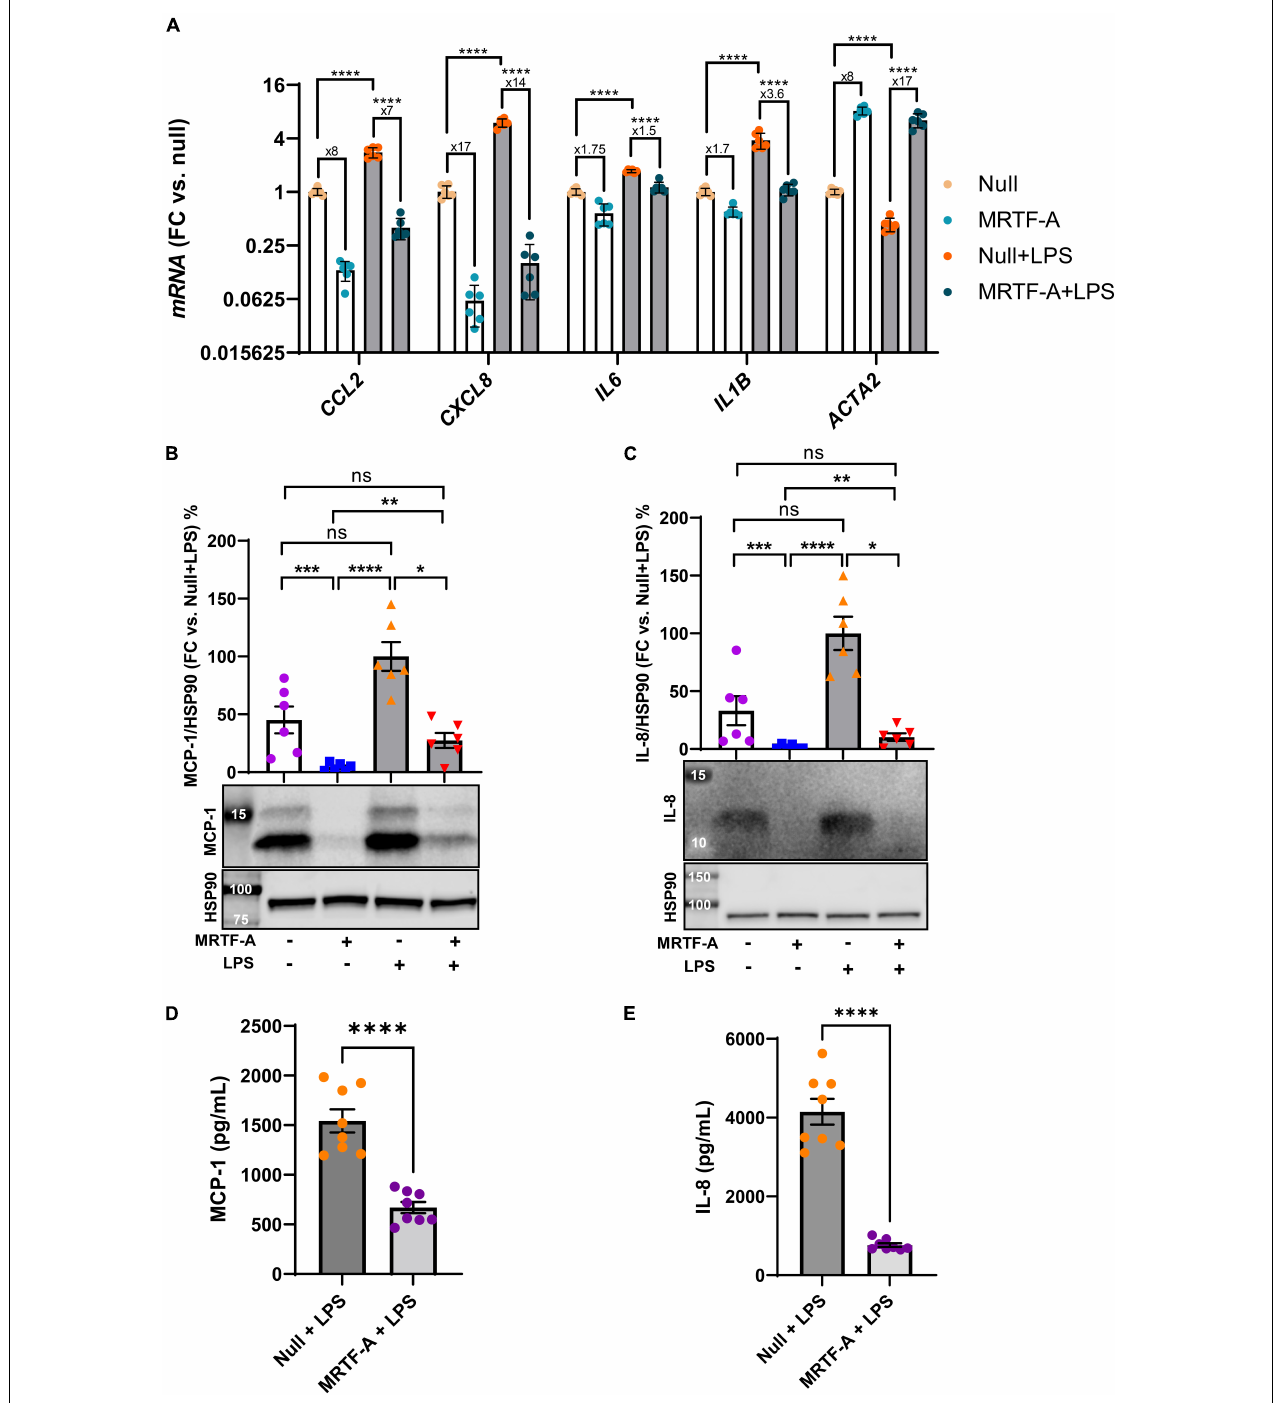
FIGURE 2 | The anti-inflammatory impact of MRTF-A is maintained in pro-inflammatory conditions. (A) Human coronary artery smooth muscle cells in culture were transduced with Null and MRTF-A viruses in control conditions (open bars), or with simultaneous treatment with lipopolysaccharide (LPS, 500 ng/ml), to mimic a pro-inflammatory environment (gray bars). After harvesting the cells, RNA was isolated, and inflammatory transcripts were assayed using RT-qPCR. The fold repression by MRTF-A is indicated below the asterisks that indicate significance, showing that MRTF-A was similarly effective in the absence and presence of LPS. CCL2 for example was reduced eightfold in control conditions and sevenfold in LPS treated cells, and an independent analysis indicated that this difference was not significant. To support MRTF-dependent reductions of inflammatory mediators at the protein level, MCP-1 ( CCL2 , (B,D) ) and IL-8 ( CXCL8 , (C,E) ) were examined using western blotting (B,C) and ELISAs (D,E) . All assays indicted significant MRTF-A-dependent reductions at the protein level, both in the absence and presence of LPS. * P < 0.05, ** P < 0.01, *** P < 0.001, **** P < 0.0001.